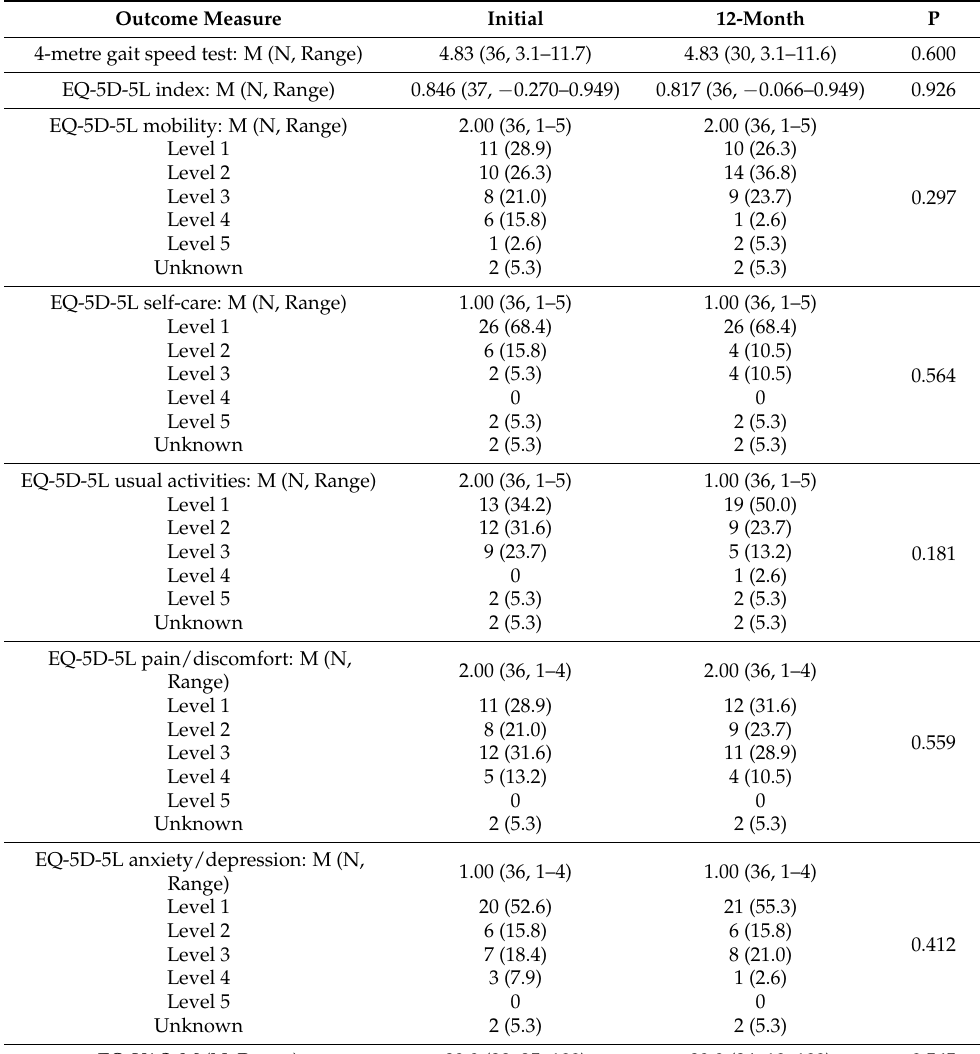
Table 4. Changes in EQ-5D-5L, EQVAS and 4-metre gait speed test from initial SCH to 12-month